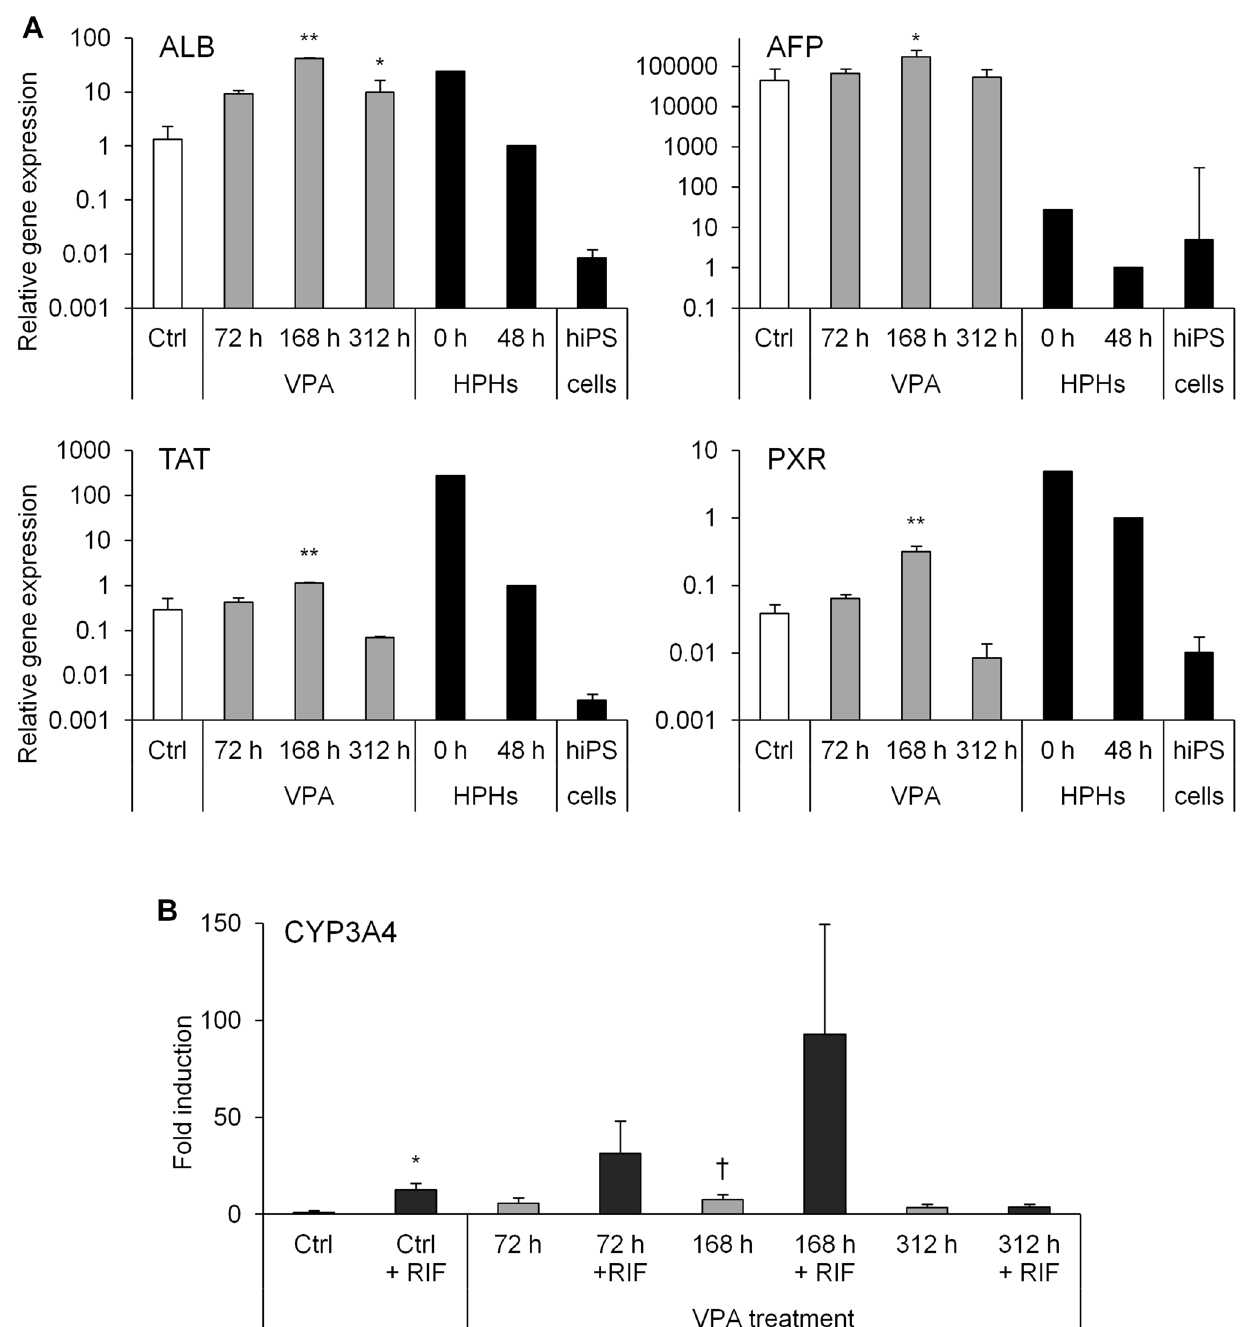
Figure 2. Effects of VPA on hepatic marker gene expression and induction of the CYP3A4 mRNA by RIF. Human iPS (hiPS) cells (Windy) were differentiated into hepatocytes. Valproic acid (VPA) was added to the medium for 72 h from day 18 (72 h), 168 h from day 12 (168 h), or 312 h from day 12 (312 h). (A) Cryopreserved human primary hepatocytes (HPHs) were cultured for 0 (just after thawing) and 48 h. Each bar represents the mean 6 standard deviation ( n =3). The graph represents gene expression relative to that detected in HPHs cultured for 48 h. Levels of statistical significance compared with VPA-untreated hepatocyte-like cells [control (Ctrl)]: * P , 0.05 and ** P , 0.01; and (B) hiPS cell-derived hepatocyte-like cells were treated with 40- m M rifampicin (RIF) for the last 48 h of culture. Each bar represents the mean 6 standard deviation ( n =2–3). The graph represents gene expression relative to that detected in VPA-untreated hepatocyte-like cells without RIF. Levels of statistical significance compared with Ctrl in the RIF-untreated group ( { ), and RIF-treated group compared with each RIF-untreated group (*), respectively: { P , 0.05 and * P , 0.05. The abbreviations used are: AFP, a -fetoprotein; ALB, albumin; TAT, tyrosine aminotransferase; PXR, pregnane X receptor; CYP, cytochrome P450.